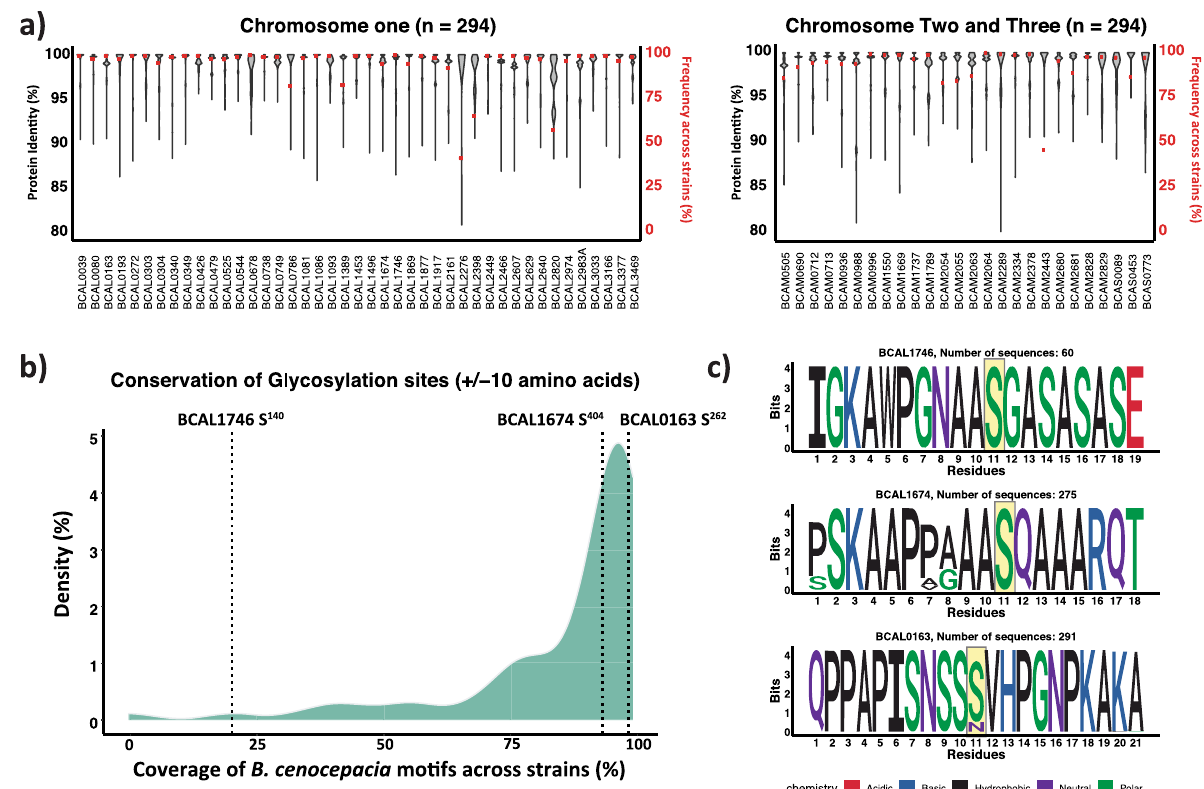
Fig. 4 Glycoproteins and glycosylation sites are conserved across B. cenocepacia . a Violin plot showing the amino acid sequence variation and frequency of 69 glycoproteins across 294 B. cenocepacia genomes. Relative frequency is shown in red (right axis) and protein sequence identity (>80% minimum) is shown in black (violin plot, left axis). b Density plot representing the conservation of the glycosylation site sequence across 69 glycoproteins within 294 B. cenocepacia genomes c Sequence logos of glycoproteins denoted within the density plot; BCAL1746 S 140 ; BCAL1674 S 404 and BCAL0163 S 262